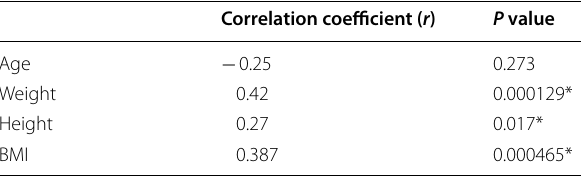
Table 2 Correlation between patient characteristics and effective dose of coronary CTA